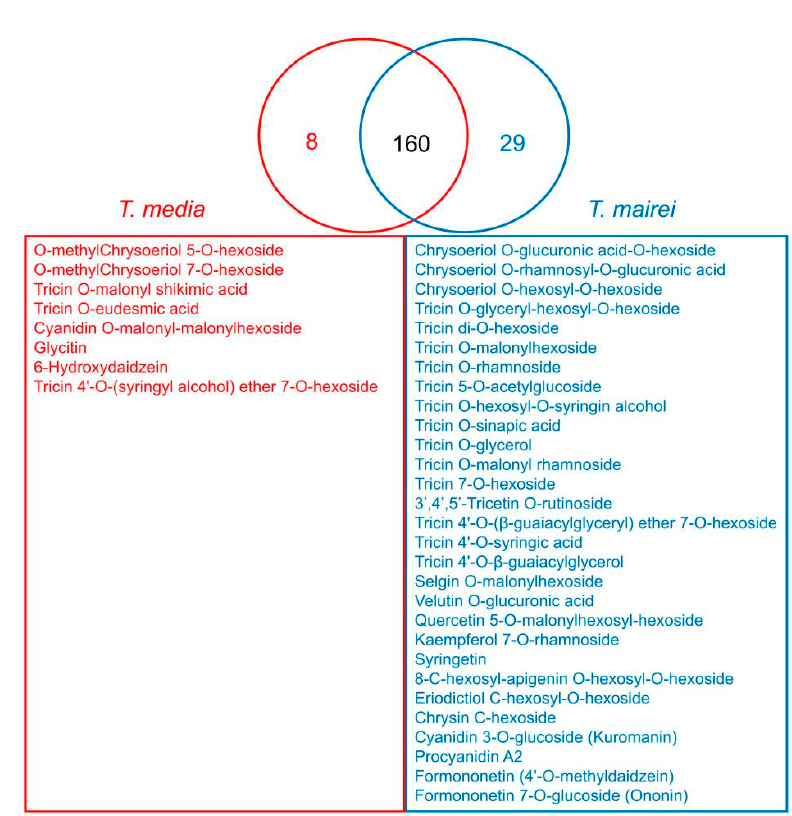
Figure 5. Venn diagram revealing the common and unique metabolites between T. mairei and T. media .